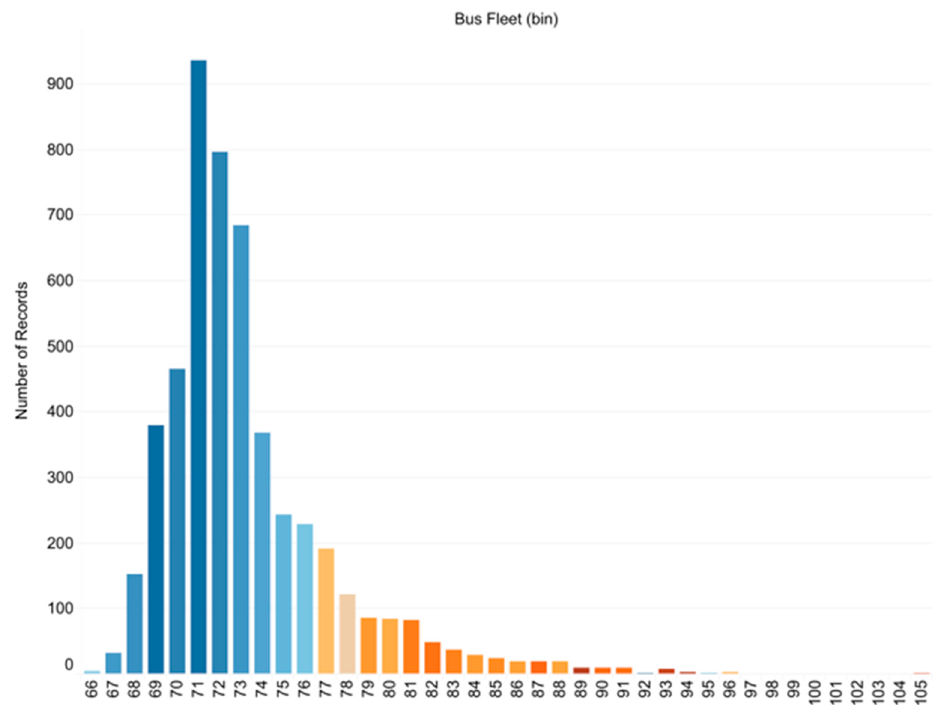
Figure 7. Histogram of number of chromosomes per fleet size (color notes user cost, with blue and red marking low and high user costs respectively).